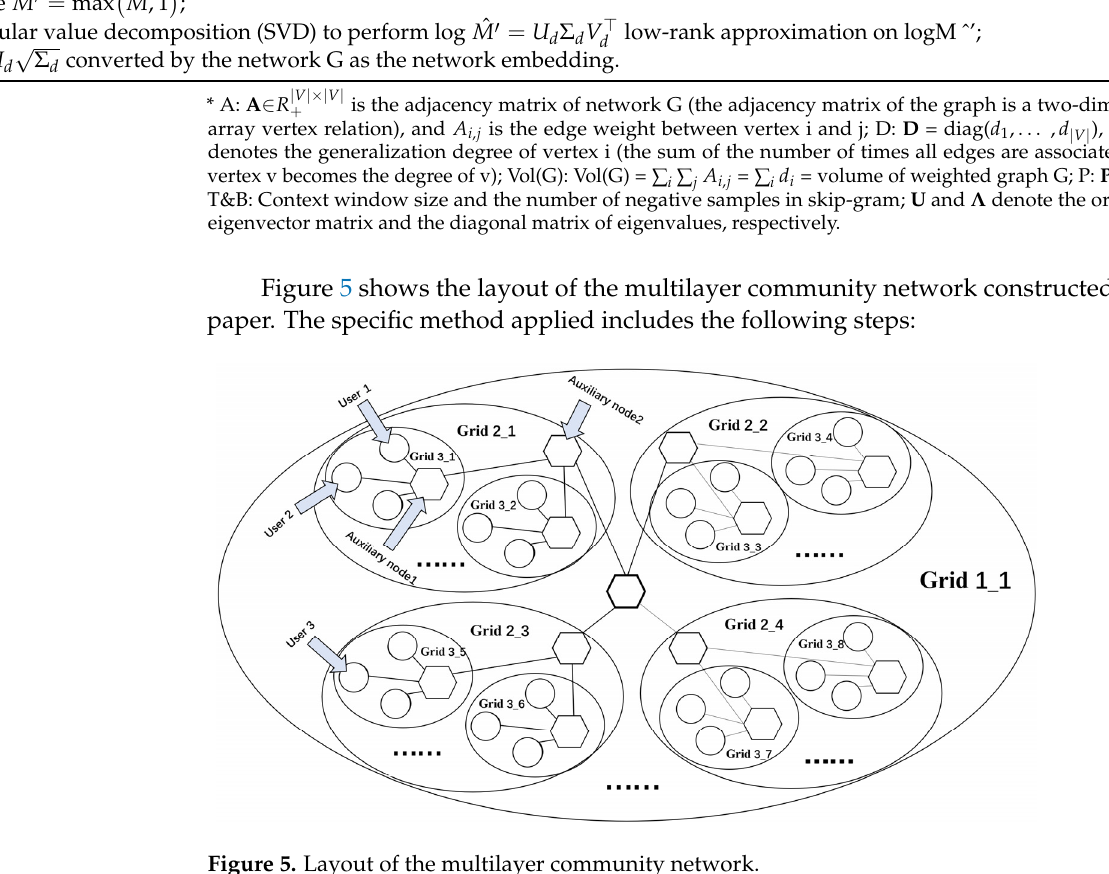
Figure 5. Layout of the multilayer community